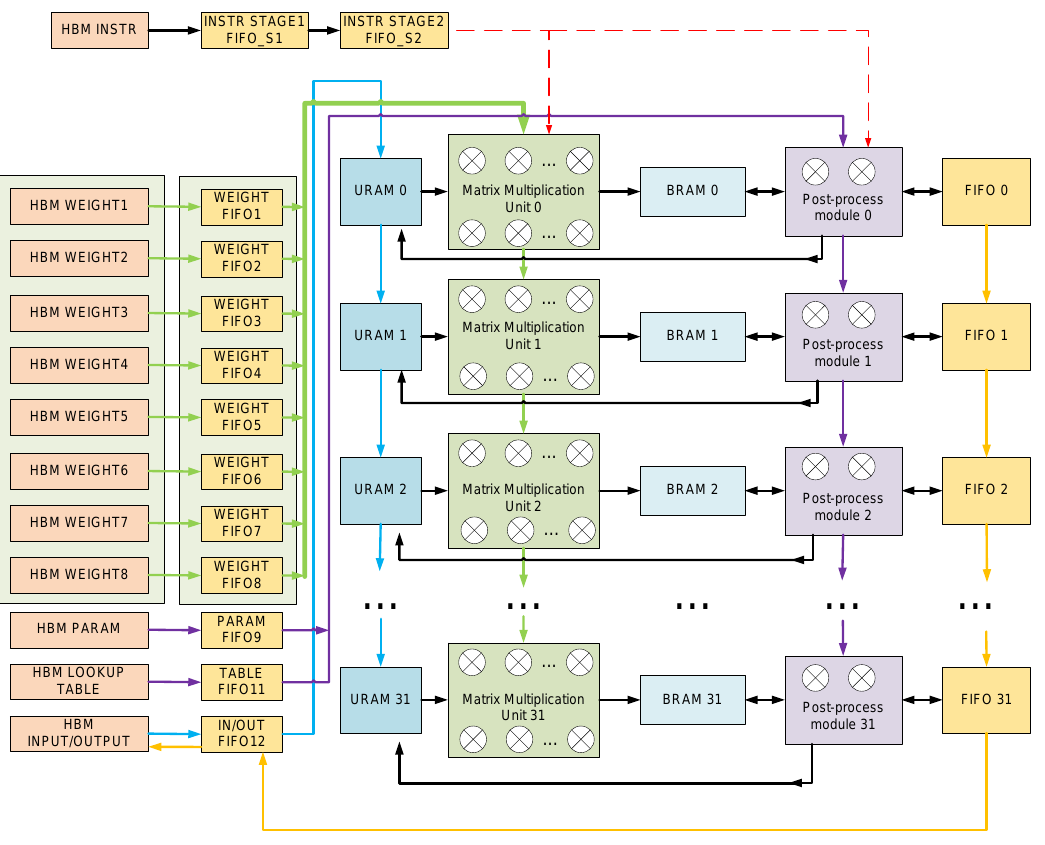
Figure 3. The architecture of the kernel (LSTM accelerator running on